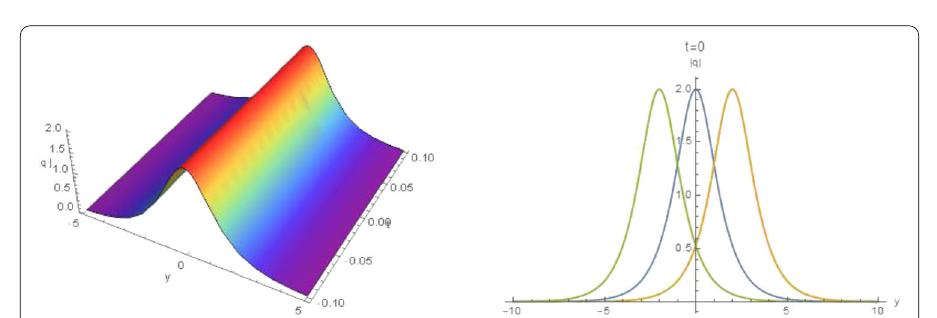
Figure 5 Graphs of the solitary wave for (3.35) with m → 1, a = 1, c = 1, k =